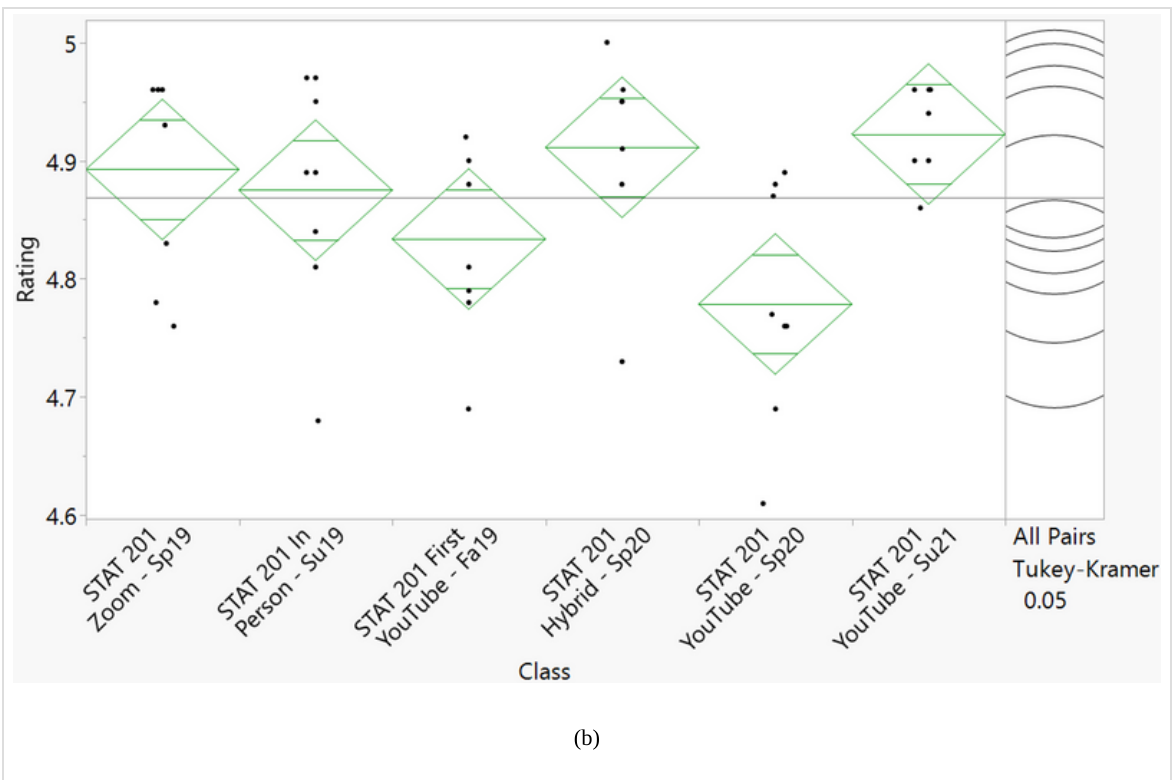
Figure 13. Graphical comparison of Stat 201 student performance and teaching evaluations across different teaching platforms—in-person, online via Zoom and YouTube, and hybrid—from 2019 to 2021. All sections were taught by Brian Stevensn at the University of Tennessee, Knoxville, with the identical